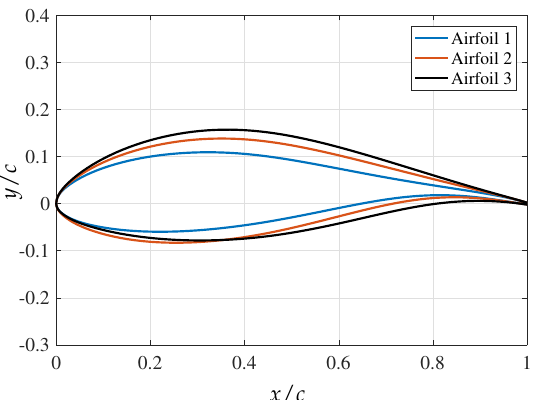
Figure 5. The lift-to-drag ratios of wind turbine airfoils 1 , 2 and 3 are 57.1, 98.7 and 114.5 when they are simulated at (Re = 4.23 × 10 5 , AOA = 1.01 ◦ ), (Re = 5.06 × 10 5 , AOA = 7.13 ◦ ) and (Re = 7.35 × 10 5 , AOA = 7.83 ◦ ) , respectively. At Re = 10 6 and AOA = 5 ◦ , their lift-to-drag ratios are 125.1, 121.8 and 119.3, respectively.